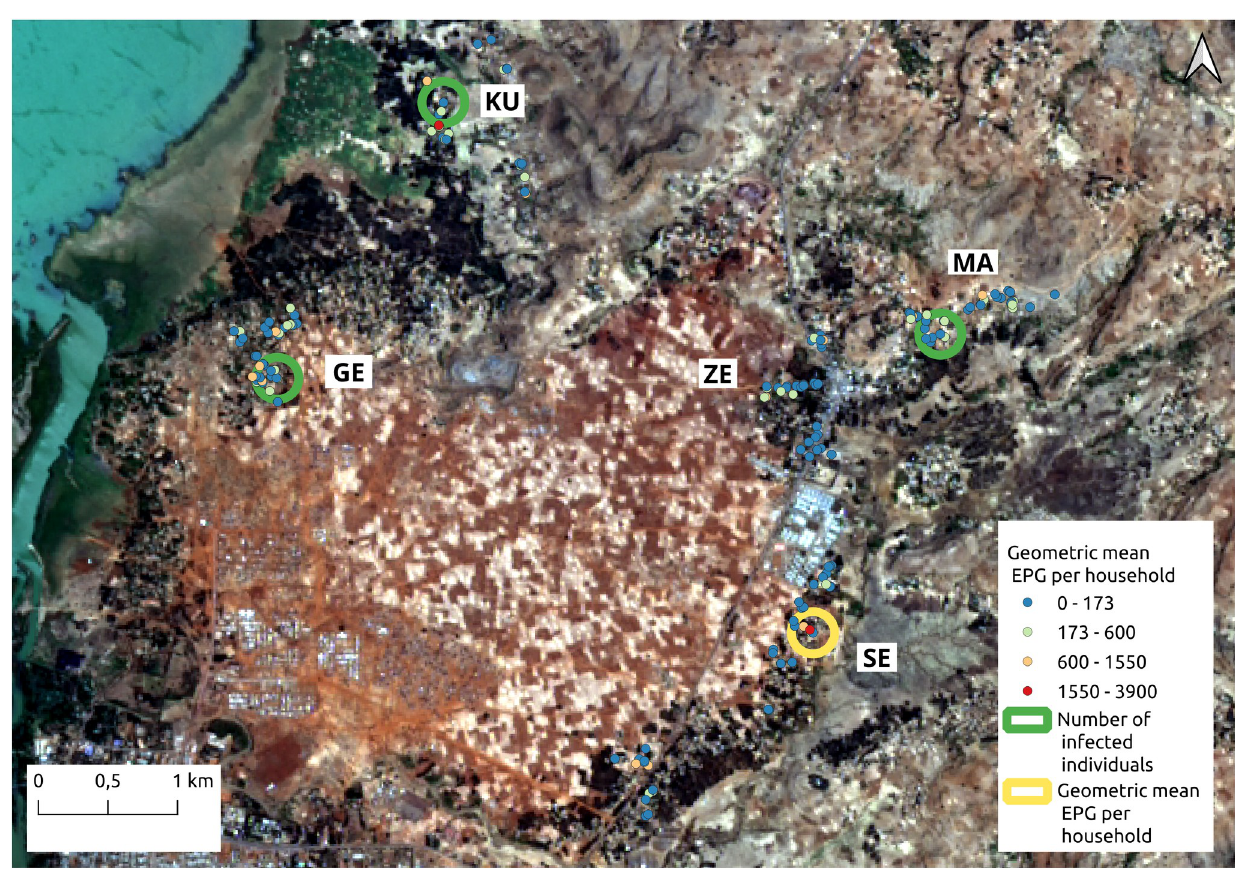
Fig 4. Spatial clusters of households with high value of geometric mean EPG per household and number of infected individuals. The color of each household point refers to the geometric mean EPG value. GE: Gedro, KU: Kurbi, MA: Mazoria, SE: Sesaberet, ZE: Zenzelema. Landsat-8 images, "Image courtesy of the U.S. Geological Survey", downloaded from the US Geological Survey server (USGS, https://www.usgs.gov) using Earth Explorer platform (https://earthexplorer.usgs.gov). The geographical location for Landsat-8 is: Path 170, Row 52. DATE_ACQUIRED =